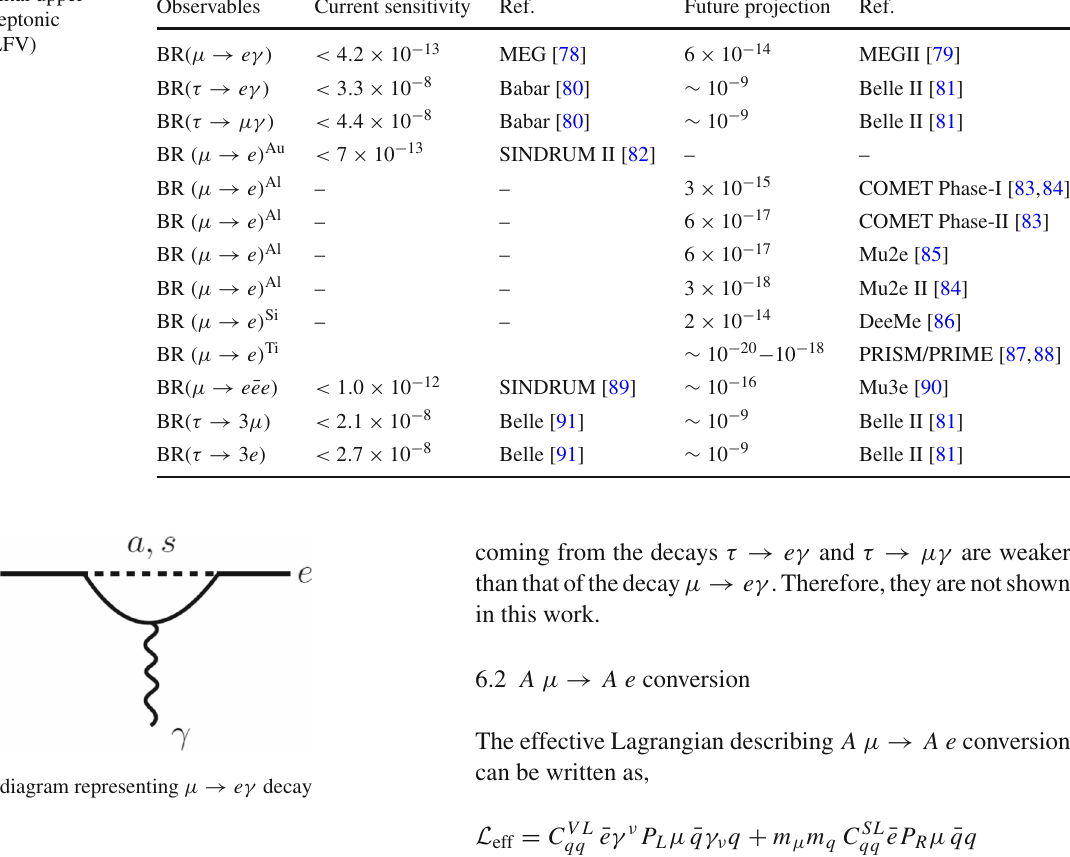
green boundary, are quite stringent relative to that of the min- imal model. Moreover, for the future projected sensitivities of the MEGII experiment, the constraints are further stronger depicted by the magenta coloured boundary. The constraints